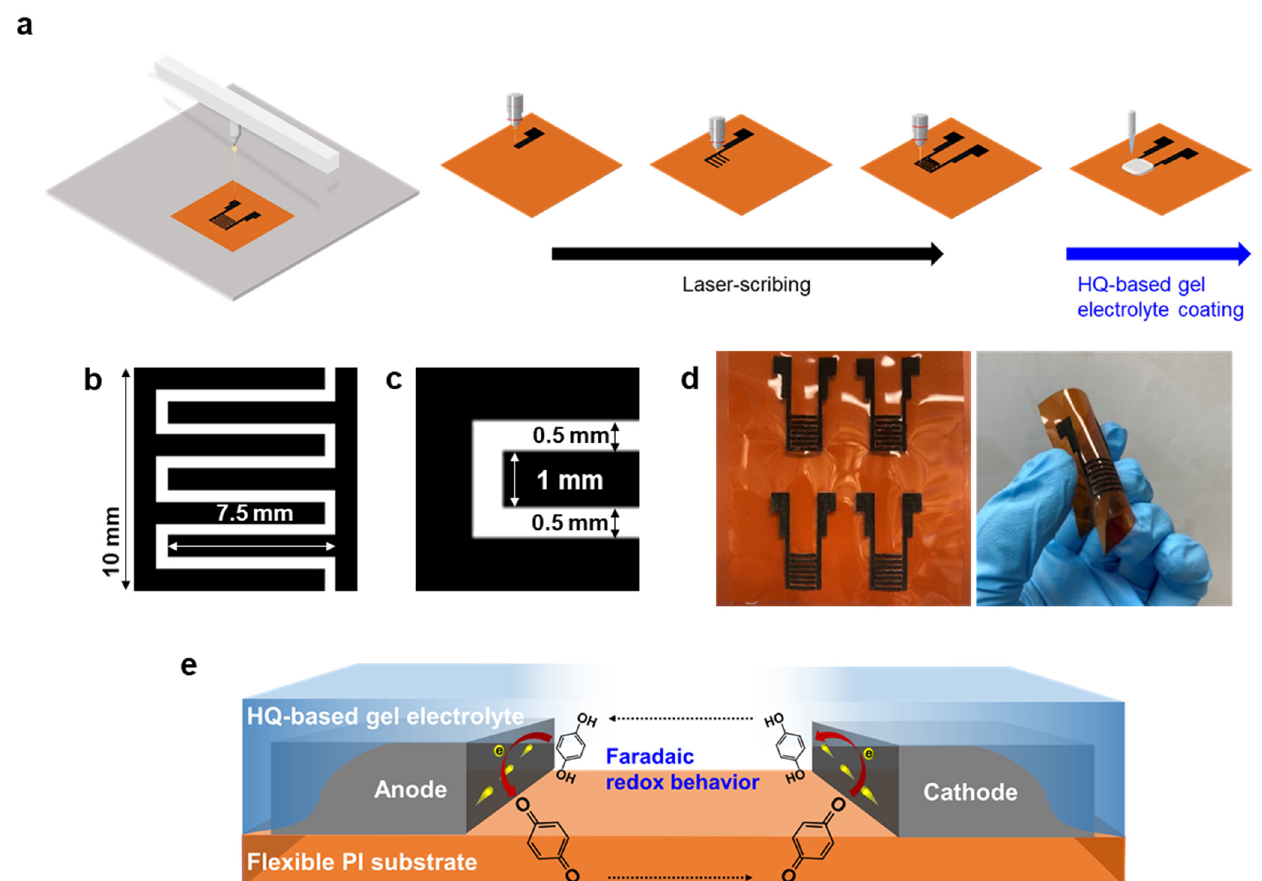
Figure 1. ( a ) Illustration of fabrication process for the interdigitated carbon-based micro-supercapacitors with HQ-gel (HQ-MSCs) based on a laser scribing method and HQ-based gel electrolyte. ( b , c ) Schematic image for pattern structure of MSCs. ( d ) Photograph of MSCs prepared by a laser scribing process. ( e ) Schematic illustration of electrochemical Faradaic redox behaviors of HQ in HQ-MSCs.